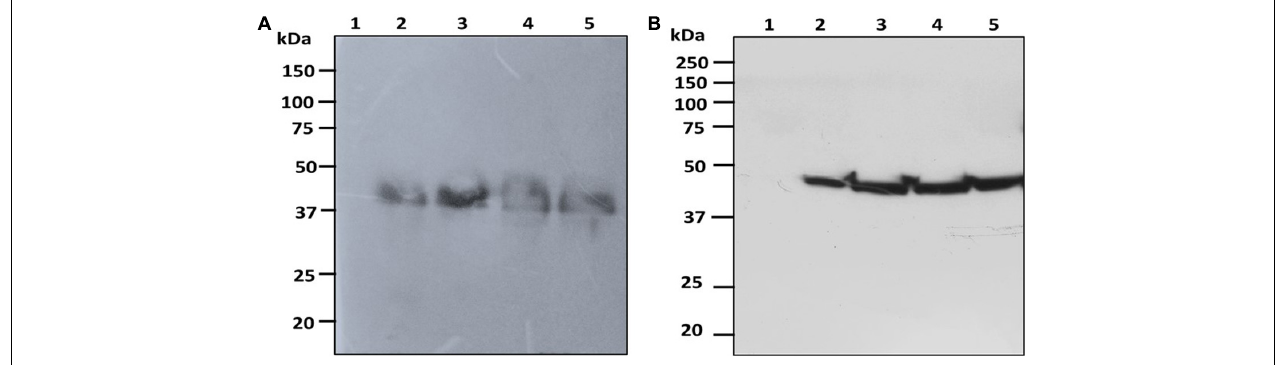
FIGURE 3 | Western blot analysis of RBD protein of SARS-CoV-2 produced in microalgal species. The crude proteins were extracted from Chlorella (A) and Chlamydomonas (B) and the expression of RBD protein was analyzed on SDS-PAGE followed by Western blot probed with a rabbit anti-his antibody conjugated with HRP. Lane 1: Wild Type; Lane 2: Sample collected after 24 h of Agrobacterium transformation and cefotaxime addition; Lane 3: Sample collected after 48 h; Lane 4: Sample collected after 72 h; Lane 5: Positive control (Agro-infiltrated crude extract of N. benthamiana ).